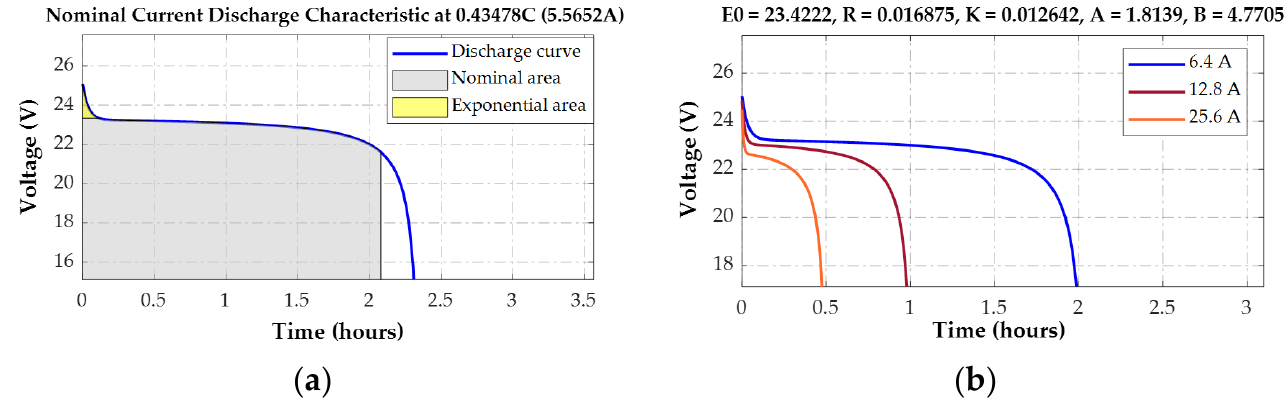
Figure 5. Polarization curves of the BAT. ( a ) Nominal current discharge characteristics. ( b ) Discharge current.